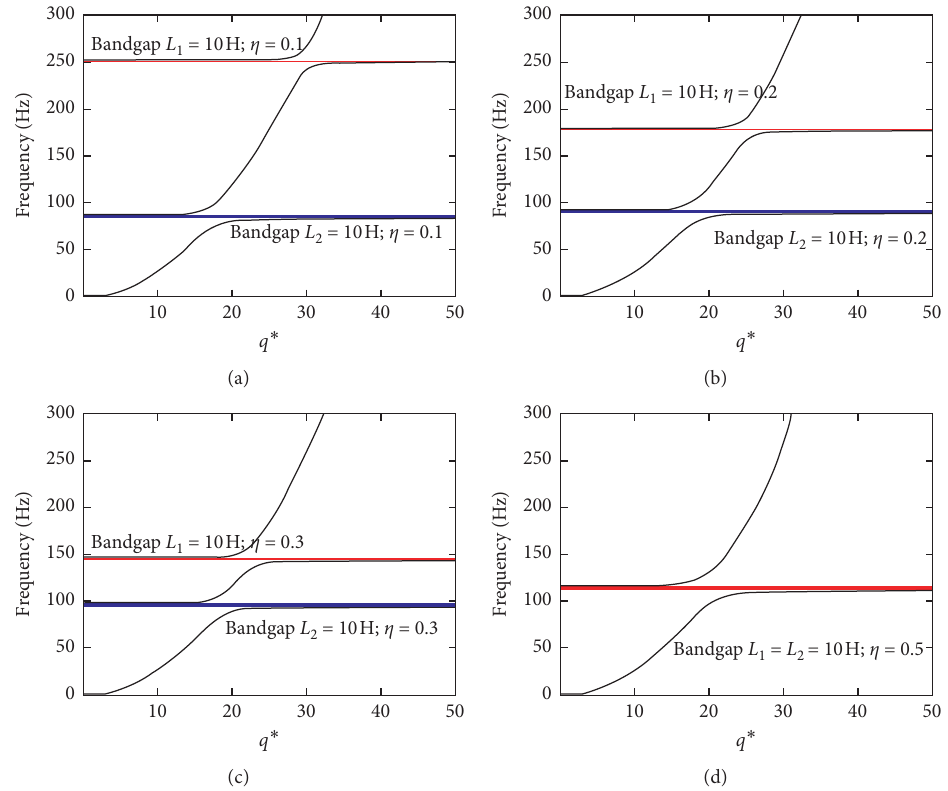
Figure 7: The locally resonant band structures of the metamaterial beam in pure inductance circuit, (a) η � 0.1, (b) η � 0.2, (c) η � 0.3, and (d) η � 0.5.